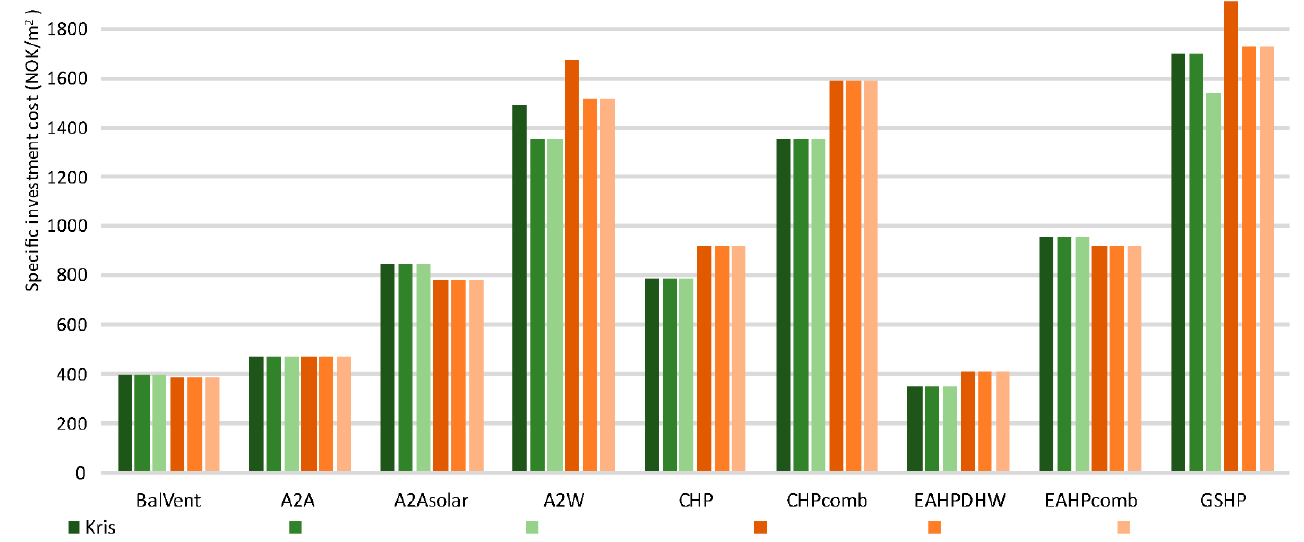
Energies 2022 , 15 , x FOR PEER REVIEW 10 of 30 Figure 2. Total specific investment costs for HVAC combinations. Figure 2. Total specific investment costs for HVAC combinations.